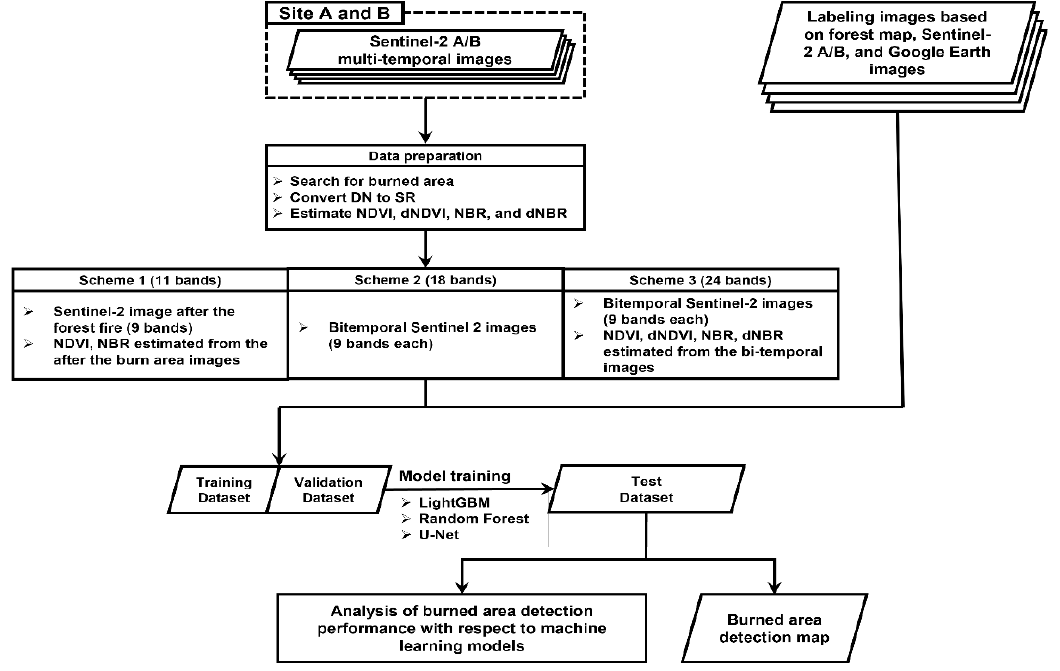
Figure 3. Flow chart of the burned area detection by applying three schemes.